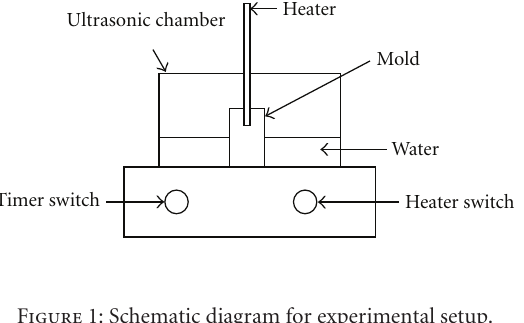
Figure 1: Schematic diagram for experimental setup.